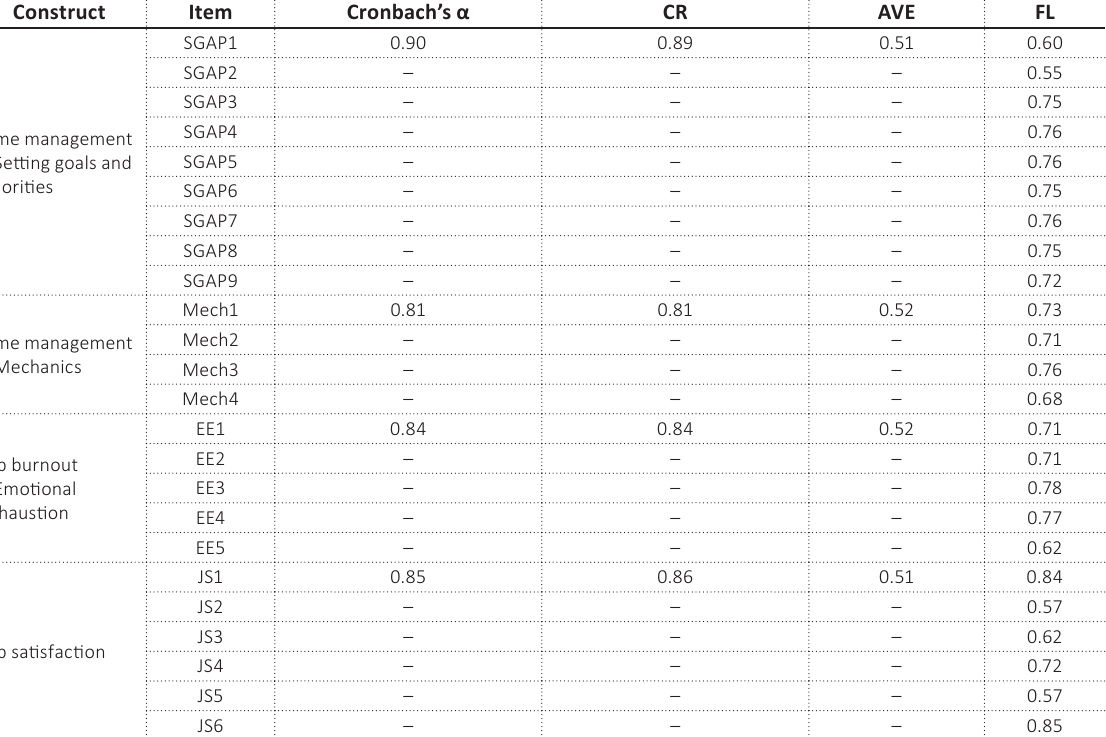
Table 2. Measurement model